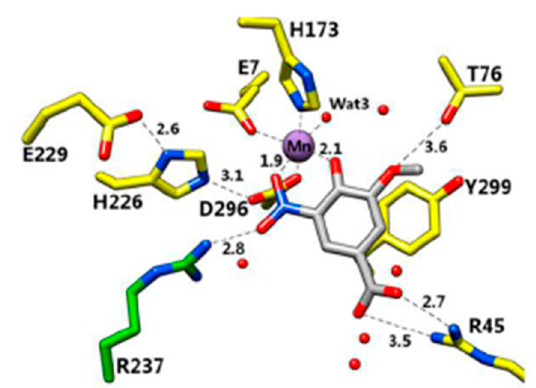
Figure 17. Structure of the active site of the LigW enzyme from Sphingomonas paucimobilis SYK-6 containing a Mn 2+ cation in an octahedral environment. Reproduced with permission from [58]. Copyright 2016, American Chemical